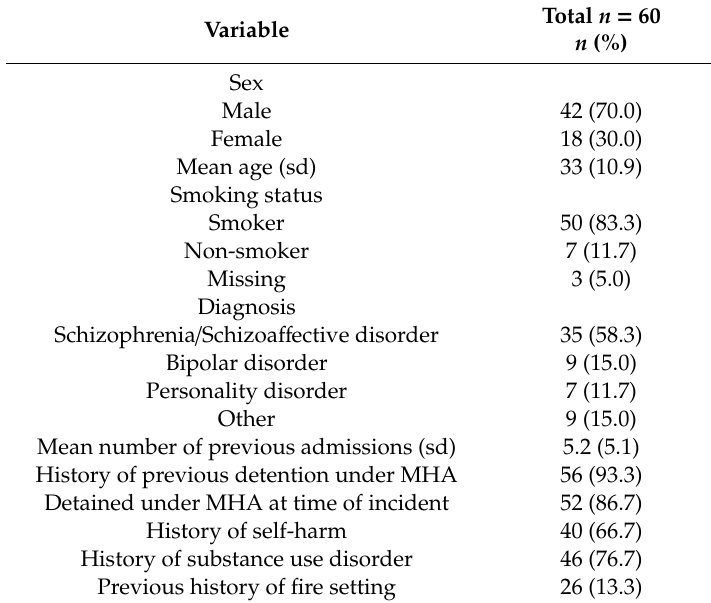
Table 1. Available demographic and clinical characteristics of inpatients who started